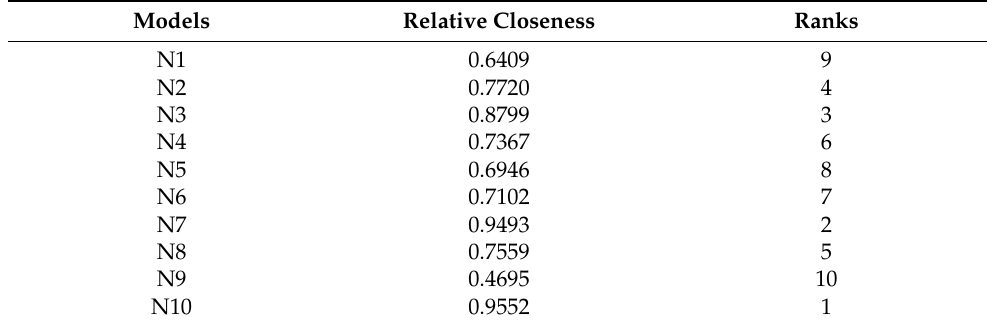
Table 12. Ranking normalization in Legendre network for Coinbase Pro